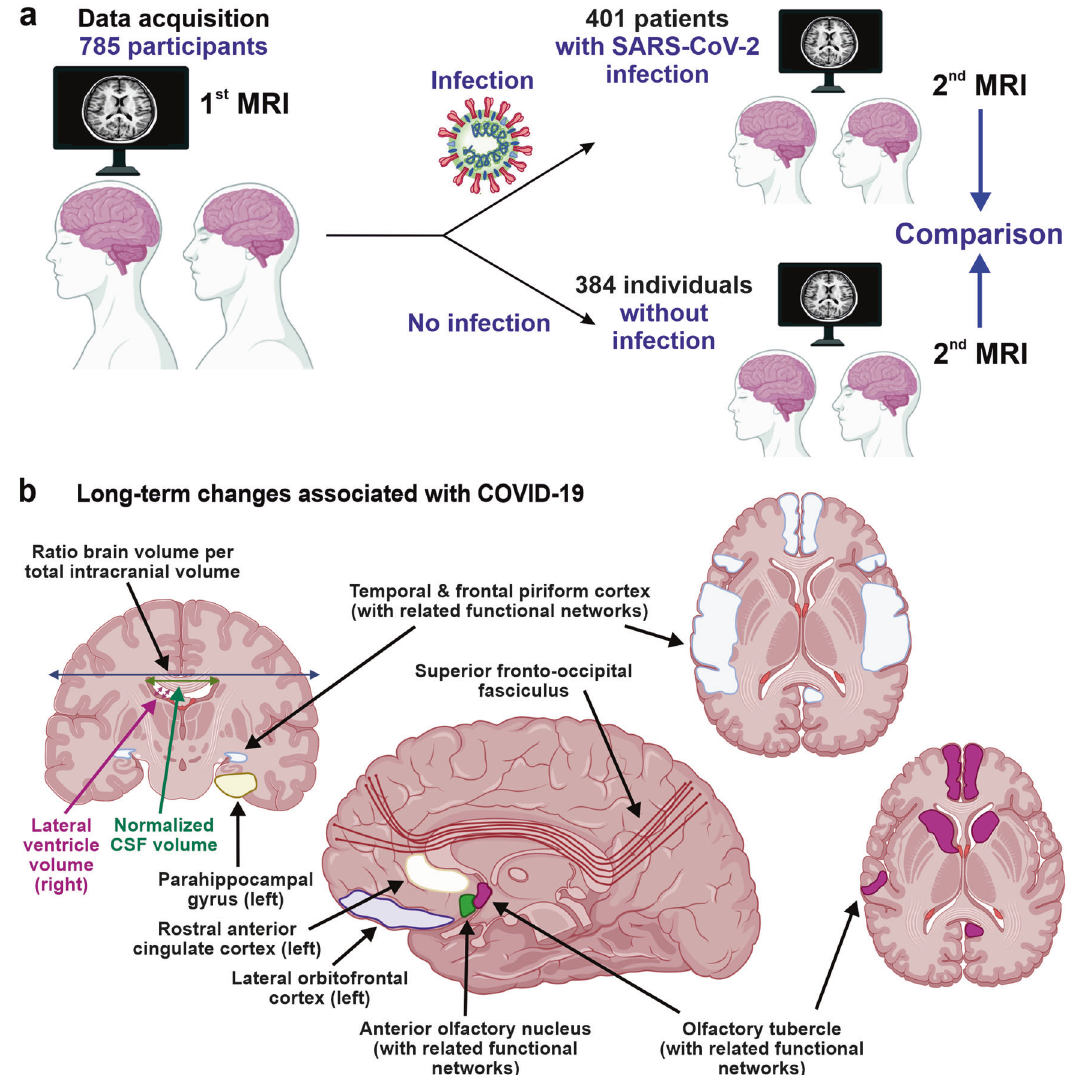
Fig. 1 Identi fi cation of long-term changes associated with COVID-19. a Data acquisition: Two cerebral MRI acquisitions were performed with a mean inter-scan interval of 3.2 years in patients with and without intermittent SARS-CoV-2 infection ( n = 384 patients without SARS-CoV-2 infection and n = 401 patients with SARS-CoV-2 infection). The fi rst MRI acquisitions were then compared to the second MRI acquisitions using multi-parametric analyses. b Changes associated with COVID-19: Longitudinal changes between control subjects and patients with SARS-CoV- 2 infection comparing the fi rst and second MRI acquisitions. Based on a hypothesis-driven analysis ( n = 297 olfactory-related cerebral imaging-derived phenotypes [IDPs]) as well as an exploratory analysis of changes beyond the olfactory system ( n = 2047 IDPs), the ten respective main fi ndings indicative of impaired brain structure and function are illustrated: ratio brain volume/estimated total intracranial volume, brain volume without ventricles & supratentorial volume without ventricles (dark blue arrow); normalized cerebrospinal fl uid (CSF) volume (green arrow); lateral ventricle volume (right; purple arrows); parahippocampal gyrus (left; dark yellow); temporal and frontal piriform cortex (light blue, with related functional networks); olfactory tubercle (pink, with related functional networks); anterior olfactory nucleus (green; with related functional networks, not highlighted in the fi gure); lateral orbitofrontal cortex (left; purple); rostral anterior cingulate cortex (left; light yellow); superior fronto-occipital fasciculus (brown, illustrated as schematic streamlines representative of fi bers); and crus II of the cerebellum (not shown). Adapted from “ Neuroscience ” and “ COVID-19 ” by BioRender.com (2022). Retrieved from https:// app.biorender.com/biorender-templates respiratory infections. More work needs to be done to clarify will translate into symptoms later in life such as dementia. whether the current Omicron and future variants of SARS-CoV-2 Douaud and colleagues report that none of top 10 IDPs may also cause lasting brain abnormalities and whether these correlated signi fi cantly with the time interval between SARS- can be prevented by vaccination or therapy. However, the CoV-2 infection and the 2 nd MRI acquisition, suggesting that the fi nding by Douaud and colleagues 1 that SARS-CoV-2 causes observed abnormalities might be very long-lasting. Currently, many restrictions and protective measures are structural changes in the brain that may be permanent and relaxed because Omicron is highly transmissible but usually could relate to neurological decline is of concern and illustrates causes mild to moderate acute disease. This raises hope that that the pathogenesis of this virus is markedly different from SARS-CoV-2 may evolve towards reduced pathogenicity and that of circulating human coronaviruses. Further studies, to become similar to circulating coronaviruses causing mild elucidate the mechanisms underlying COVID-19-associated Signal Transduction and Targeted Therapy (2022)